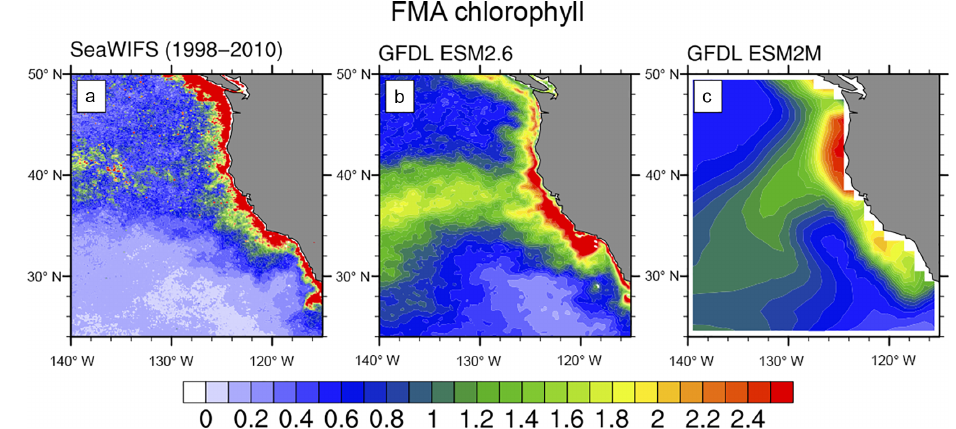
Figure 3. FMA interannual standard deviation of surface chlorophyll concentrations (standardized by area average to produce comparable scales; unitless) for (a) 1998–2010 NASA SeaWiFS observations, (b) ESM2.6, and (c) ESM2M.